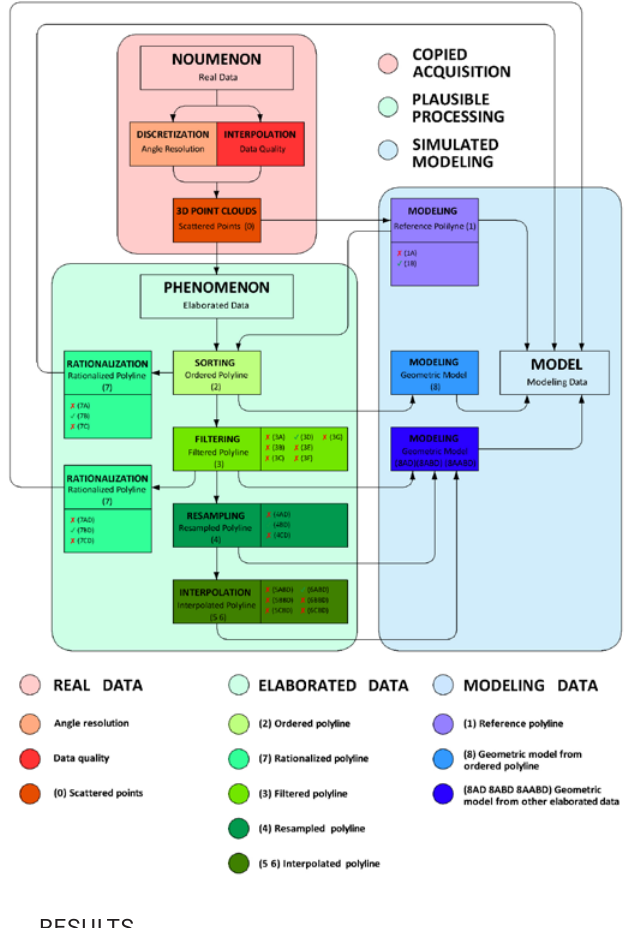
Fig. 2 Anzani, G., Methodological synthesis of the process ,